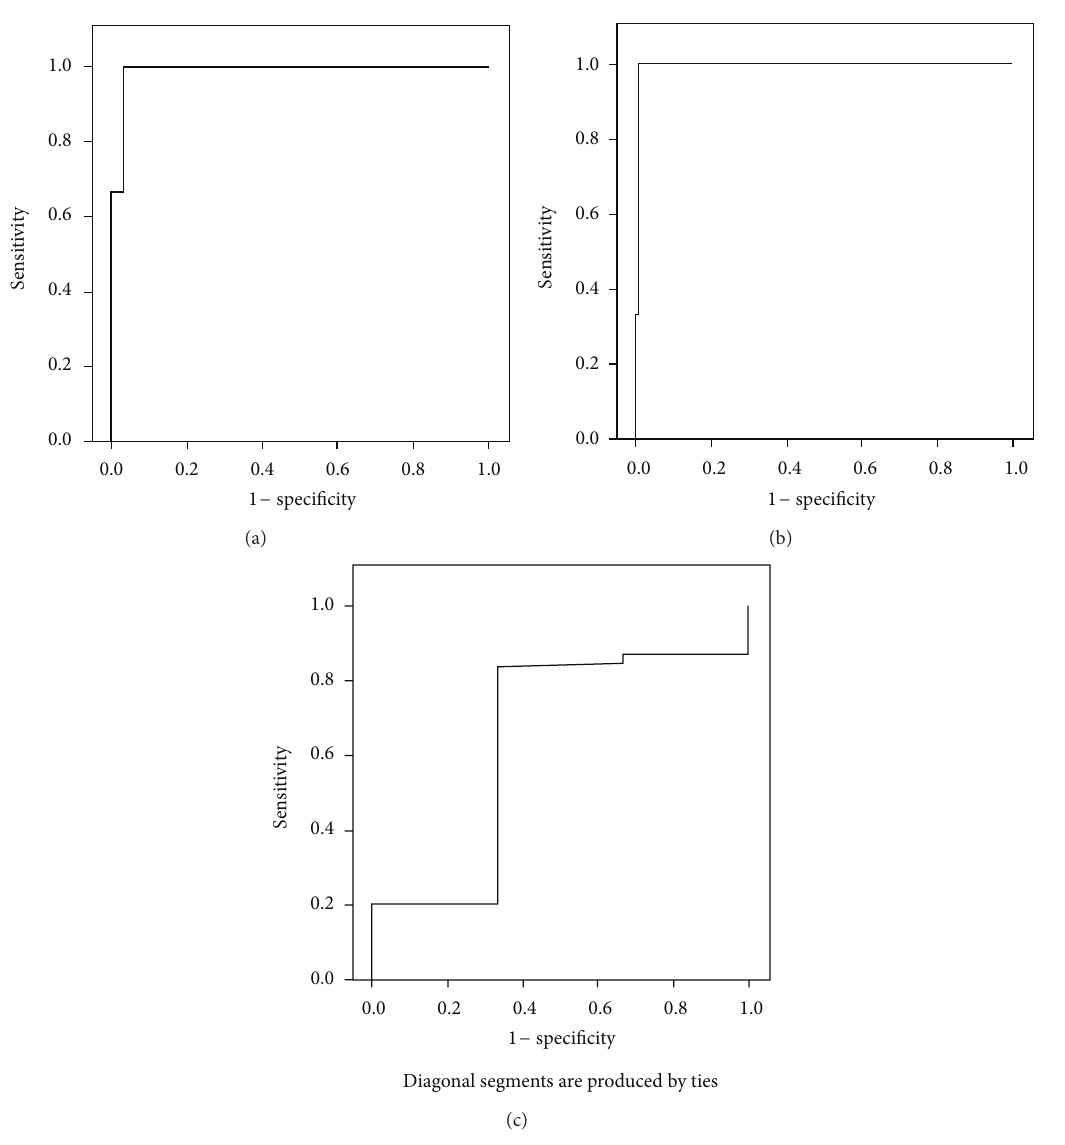
Figure 1: Receiver operator characteristic (ROC) curves to investigate the diagnostic power of a once UACR, urine albumin level, and urine creatinine level for predicting damaged kidney.